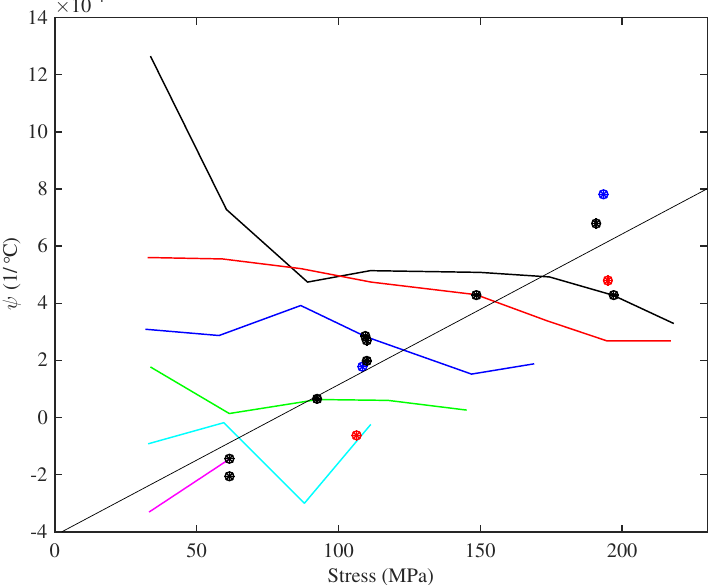
Figure 22. The thermal variation coe ffi cient ψ for the string linear density, plotted against the applied stress. Colours identify the di ff erent tested strings (Table 1): black (8:A6), red (14:A5), blue (5:A4), green (23a:A3), cyan (29:E3), magenta (10b:A2). The fitted line ( r 2 = 0.858) was matched to the data (black circles) for the operating points of the Bowbrand strings tested at the usual humidity levels (around 55–65% RH at 20 ◦ C). Blue circles show Pirastro strings; red circles show tests at low humidity (around 20–26% RH at 20 ◦